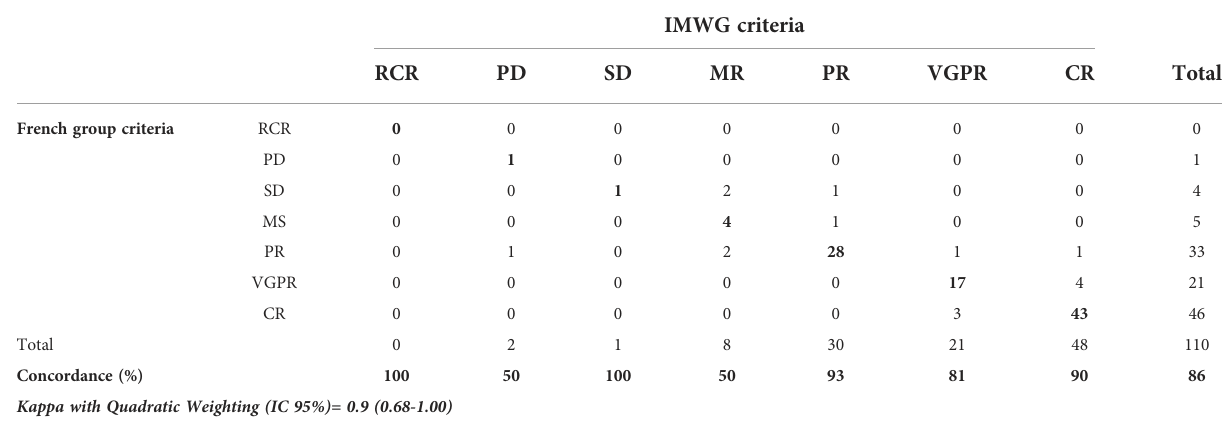
TABLE 1 Concordance between maximum responses assigned by the IMWG criteria and the French group criteria in all patients and only in LCMM patients. All